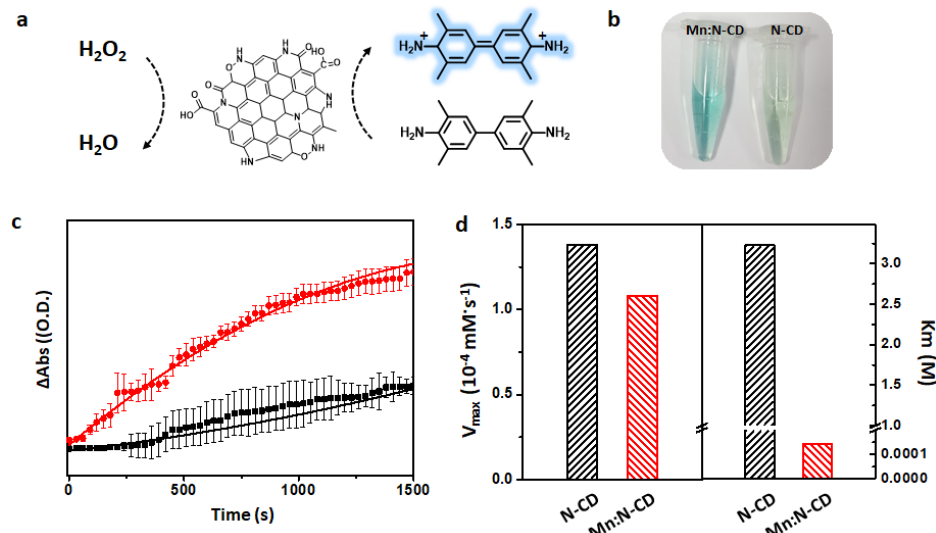
Figure 3. ( a ) Schematic of the peroxidase mimetic activity of Mn:N-CDs and ( b ) images of 3,3 (cid:48) ,5,5 (cid:48) - tetramethylbenzidine (TMB)/H 2 O 2 solutions with Mn:N-CDs or N-doped carbon dots (N-CDs). ( c ) Kinetic curves of Mn:N-CDs and N-CDs for monitoring the catalytic oxidation of TMB (10 mM phosphate buffer, pH = 2) with 100 mM H 2 O 2 in the presence of the Mn:N-CDs or N-CDs. ( d ) Com- parison of the V max and K m values of Mn:N-CDs and N-CDs; these were calculated from the Lineweaver–Burk plot (n =